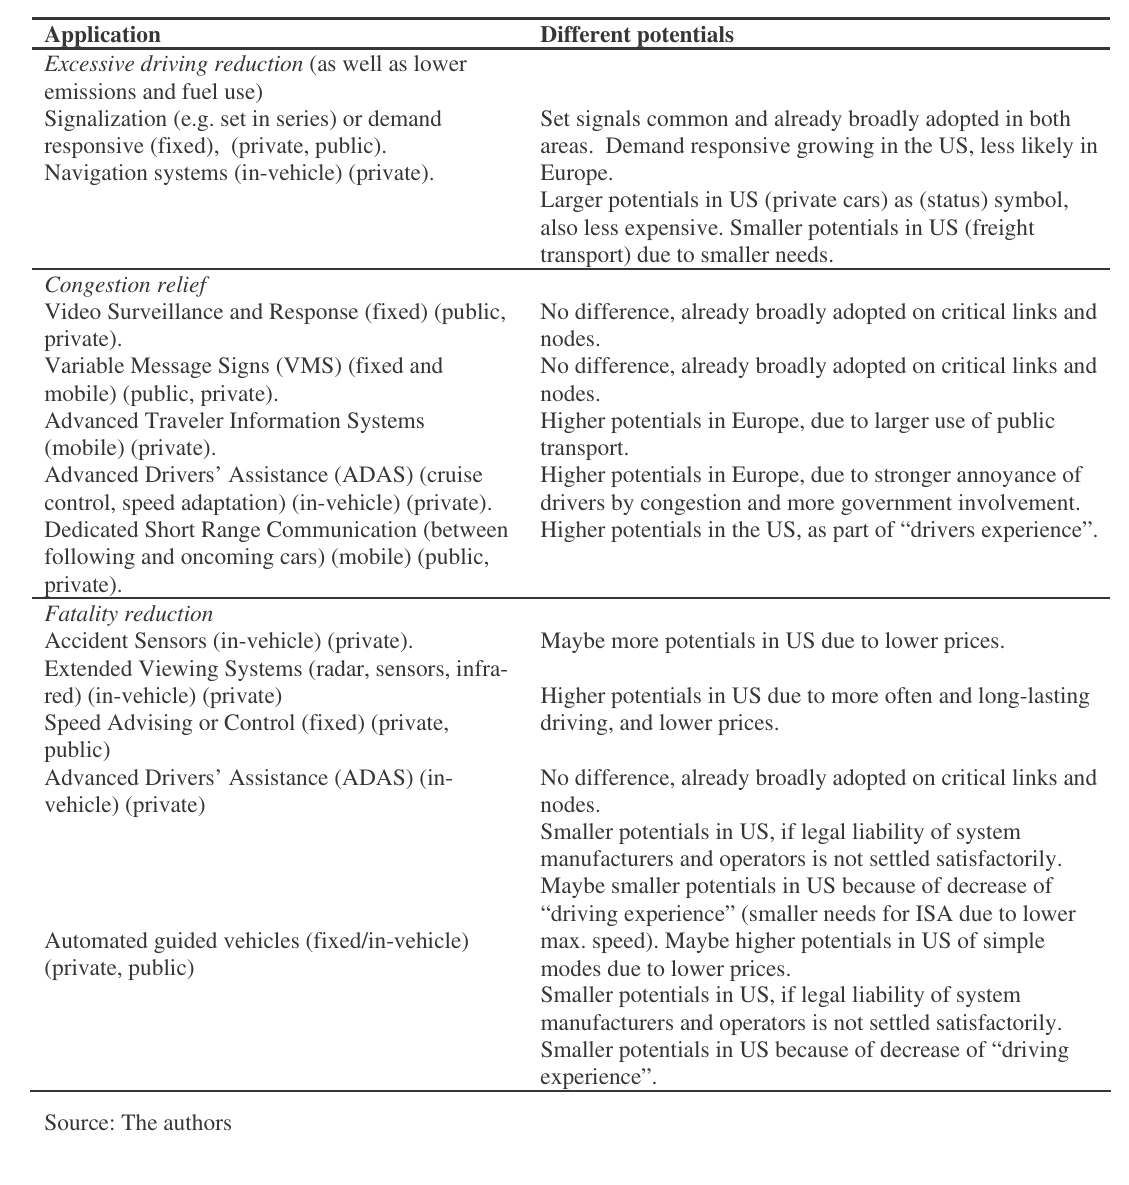
Table 5. ICT applications and potential for adoption in US and